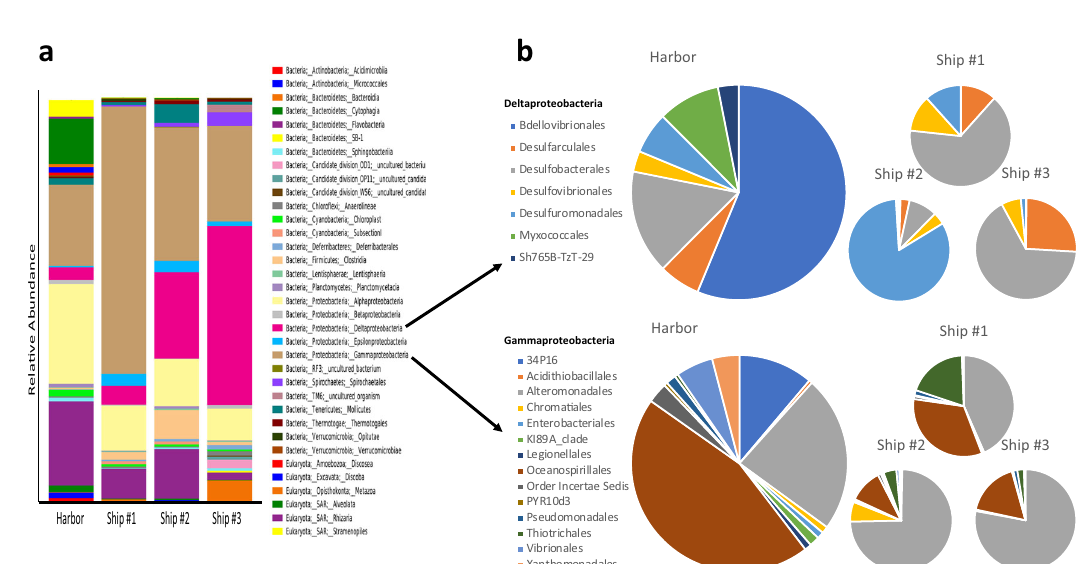
Fig. 1 Metagenome analysis of community composition in navy ship ballast systems and the San Diego Harbor seawater. Class-level depiction ( a ) and Order-level ( b ) comparison for the Delta- and Gammaproteobacteria.